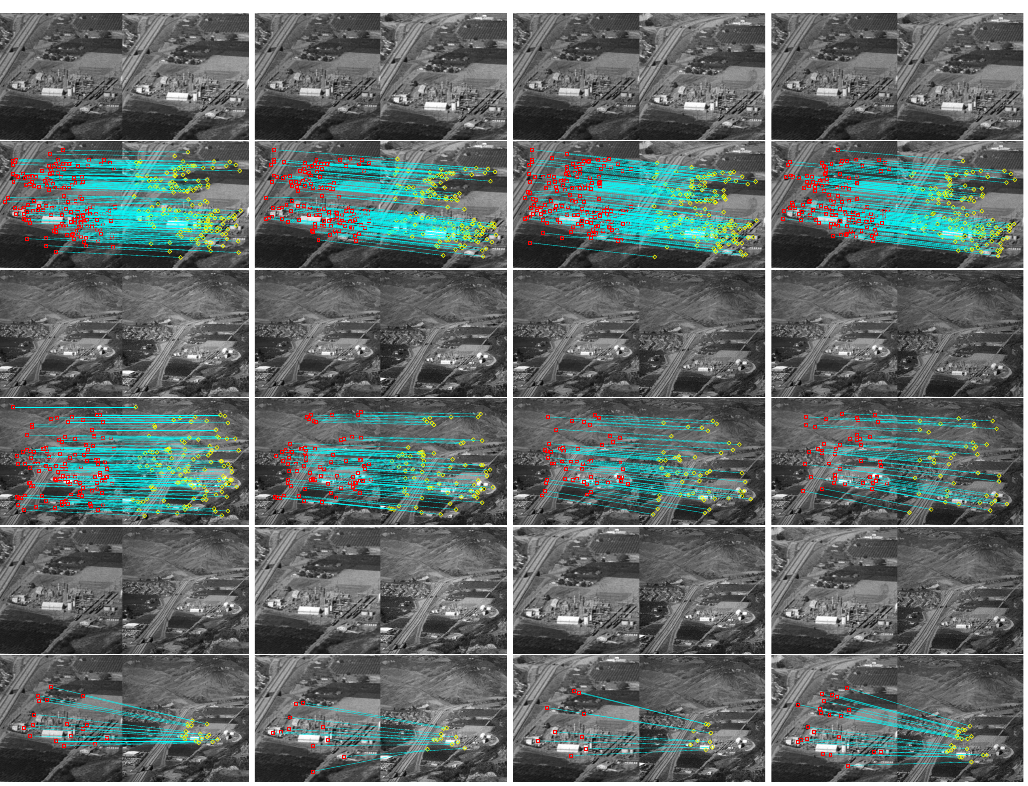
Figure 10. Remote sensing image matching test—the original frames are shown in the odd rows, and, the even ones, frames with the found key-points (marked as yellow and red points) and their locations as a blue